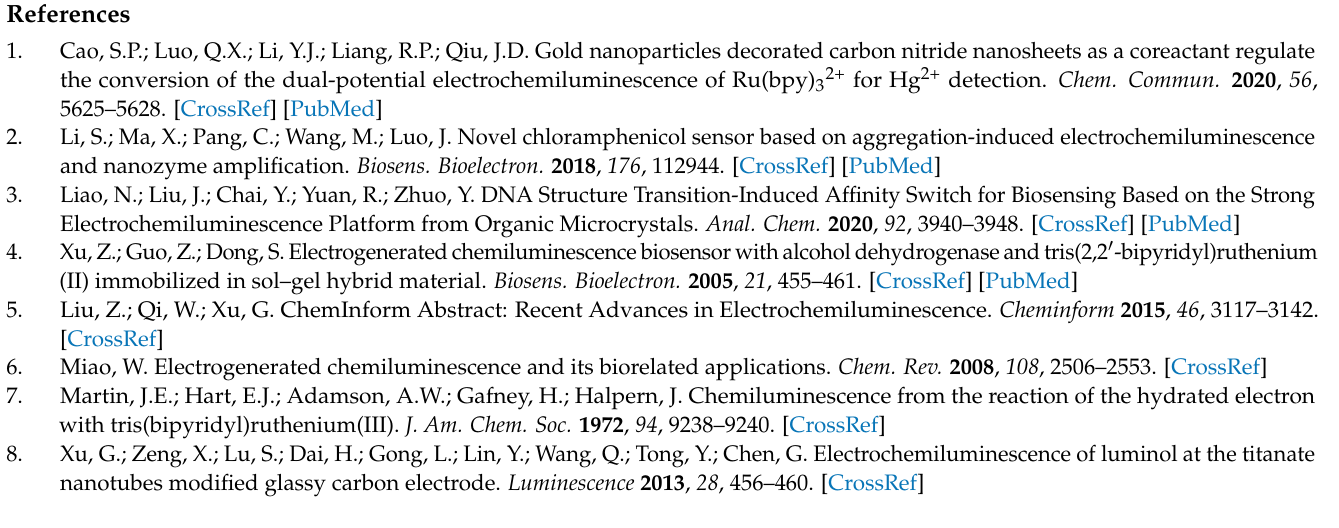
Figure S2: (A) The FT-IR patterns of MOF-253 and MOF-253@Au. (B) The XRD patterns of MOF-253 and MOF-253@Au. (C) The X-ray photoelectron spectra of MOF-253, MOF-253@Au, and Eu-MOF- 253@Au. (D) The N2 sorption isotherm at 77K for MOF-253 and Eu-MOF-253@Au; Figure S3: The variation for ECL responses of proposed sensor after long-term